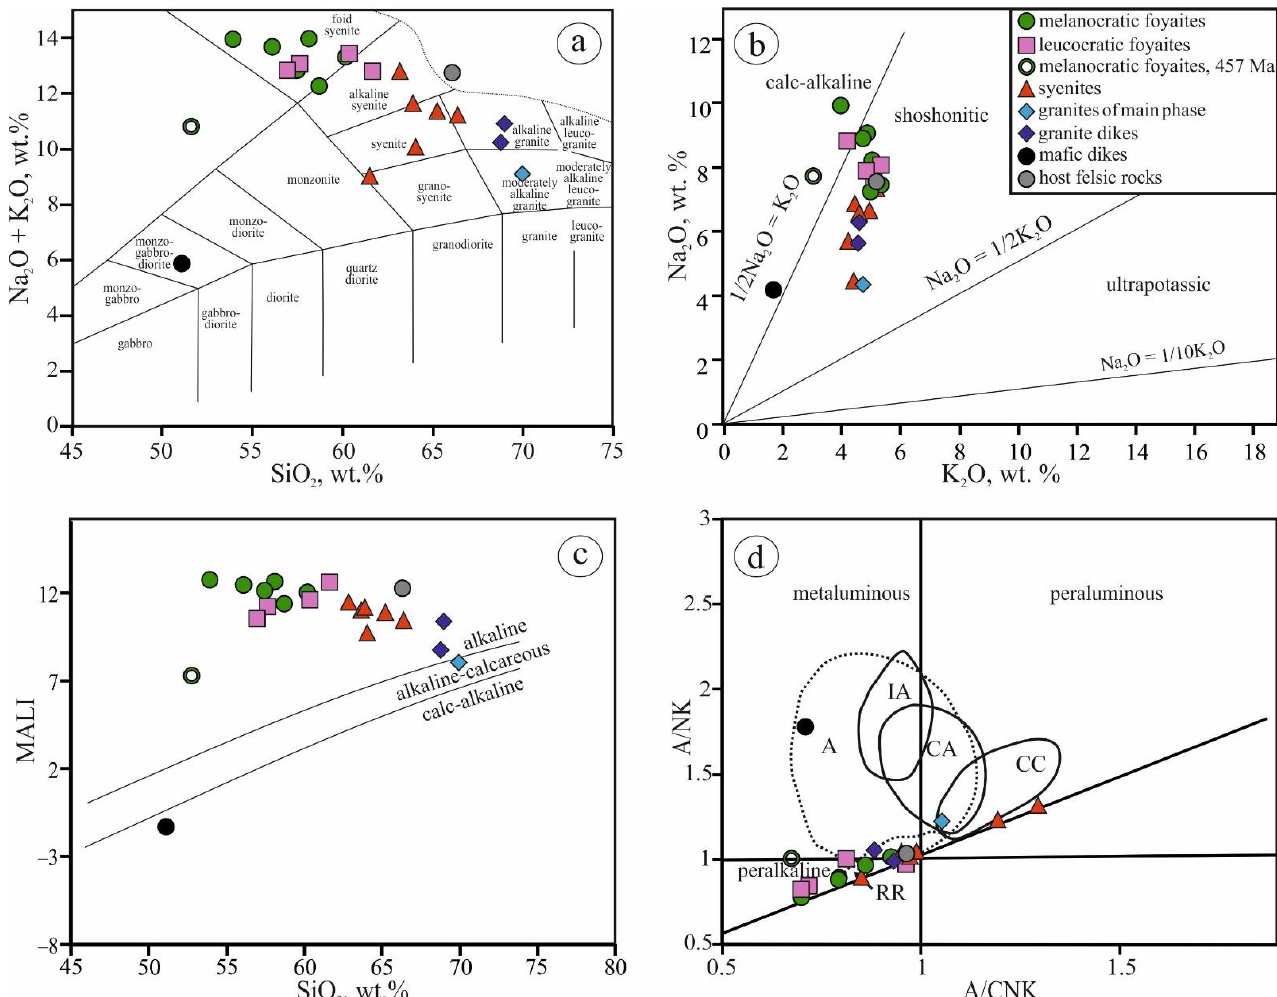
Figure 7. Major element classification of the Saibar rocks. ( a ) Total alkali vs. silica (TAS) diagram [69]; ( b ) Na 2 O vs. K 2 O alkalinity diagram; ( c ) MALI (Na 2 O + K 2 O − CaO) vs. SiO 2 diagram. ( d ) A/NK vs. A/CNK diagram. Island arc (IA), continental arc (CA), continental collision (CC), rift-related (RR), and anorogenic (A) granite fields are taken from [70].